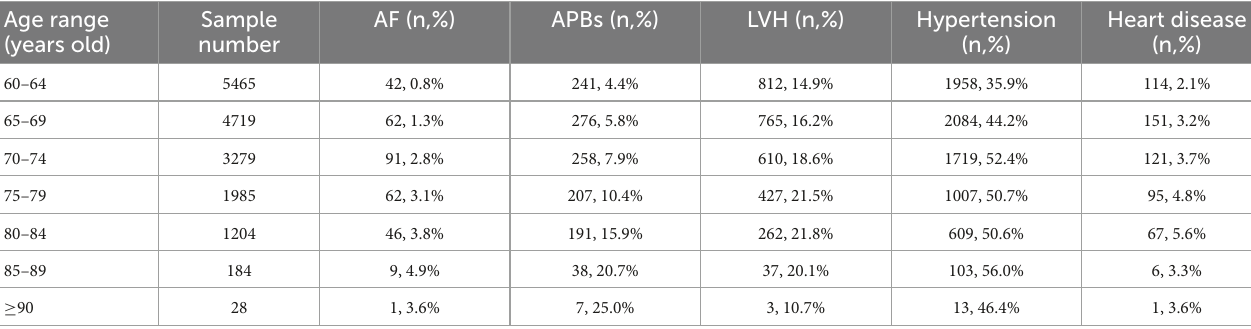
TABLE 11 The number and proportion of baseline characteristics for all subjects of different age ranges. Age range (years old)